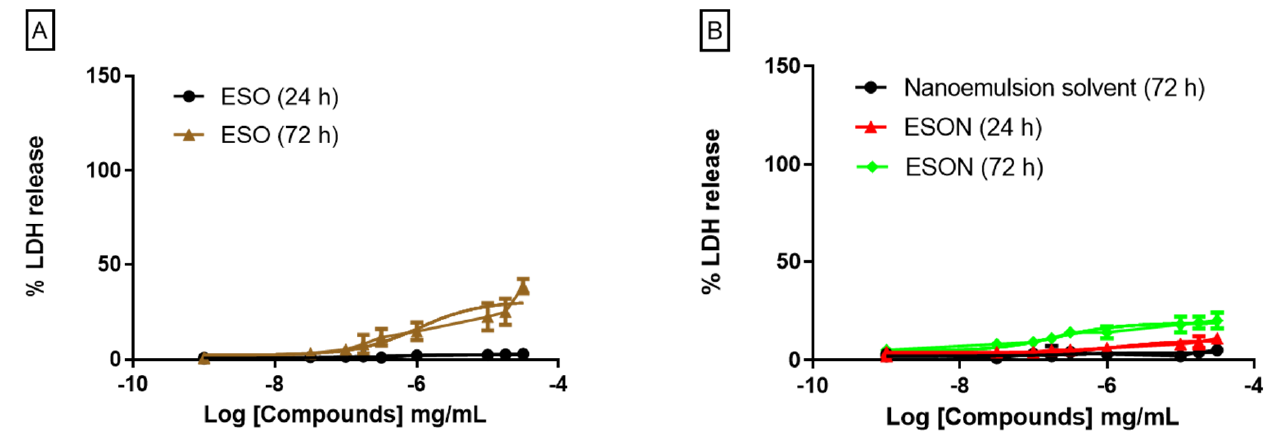
Figure 1. Cytotoxicity effect of ESO and ESON on mammalian cells evaluated by LDH release. ( A ) LDH release quantification after the stimulus with crescent ESO concentrations for 24 and 72 h; ( B ) LDH release quantification after the stimulus with crescent ESON concentrations for 24 and 72 h. Profiles are representative of 3–4 independent experiments for LDH release.